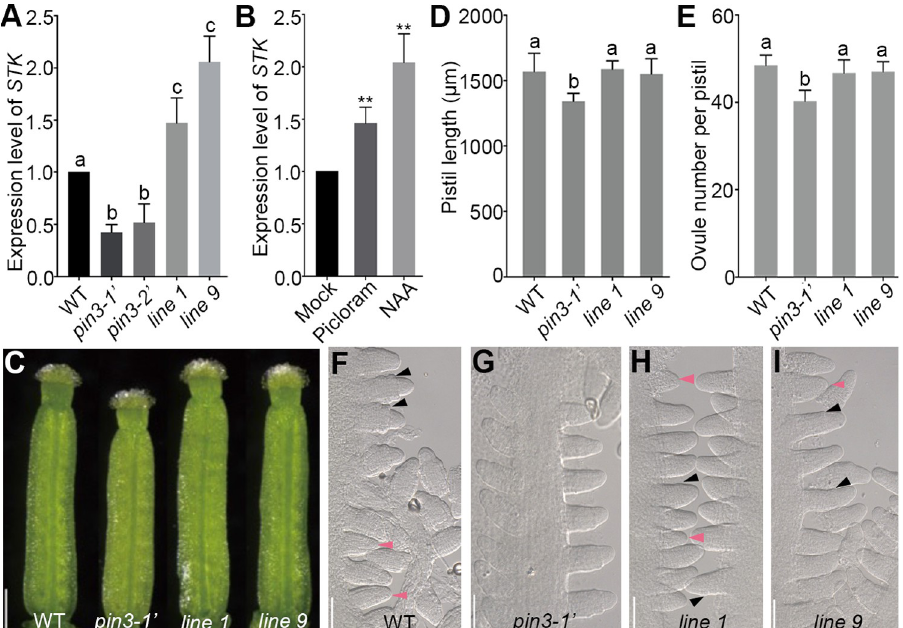
Fig 6. Overexpressing STK rescues the defective late ovule initiation of pin3-1’ mutant. (A) qRT-PCR analysis of STK expression in the pistils of the wild-type, pin3 mutants and pSTK :: STK-GFP pin3-1’ transgenic plants ( line 1 and line 9 ). (B) STK expression in the wild-type pistils was induced under 50 μ M picloram and 100 μ M NAA treatment for 1 h, respectively. The mock solution was used as a control. Three biological repeats were performed. (C) Image of pistils at floral stage 12. (D-E) Statistical assays of the pistil length (D), and ovule number per pistil (E). (F-I) DIC images showing the young ovules at floral stage 11 in the wild-type (F), pin3-1’ (no young ovules) (G), line 1 (H), and line 9 (I). Pink and black arrows represent the young ovules and integument primordia, respectively. Bars: 250 μ m (C) and 50 μ m (F-I). Data are mean ± SD. Different lowercase letters indicate the significant differences tested by one-way ANOVA. P < 0.05 (A), �� P < 0.01(B), P < 0.01 (D) and P < 0.001